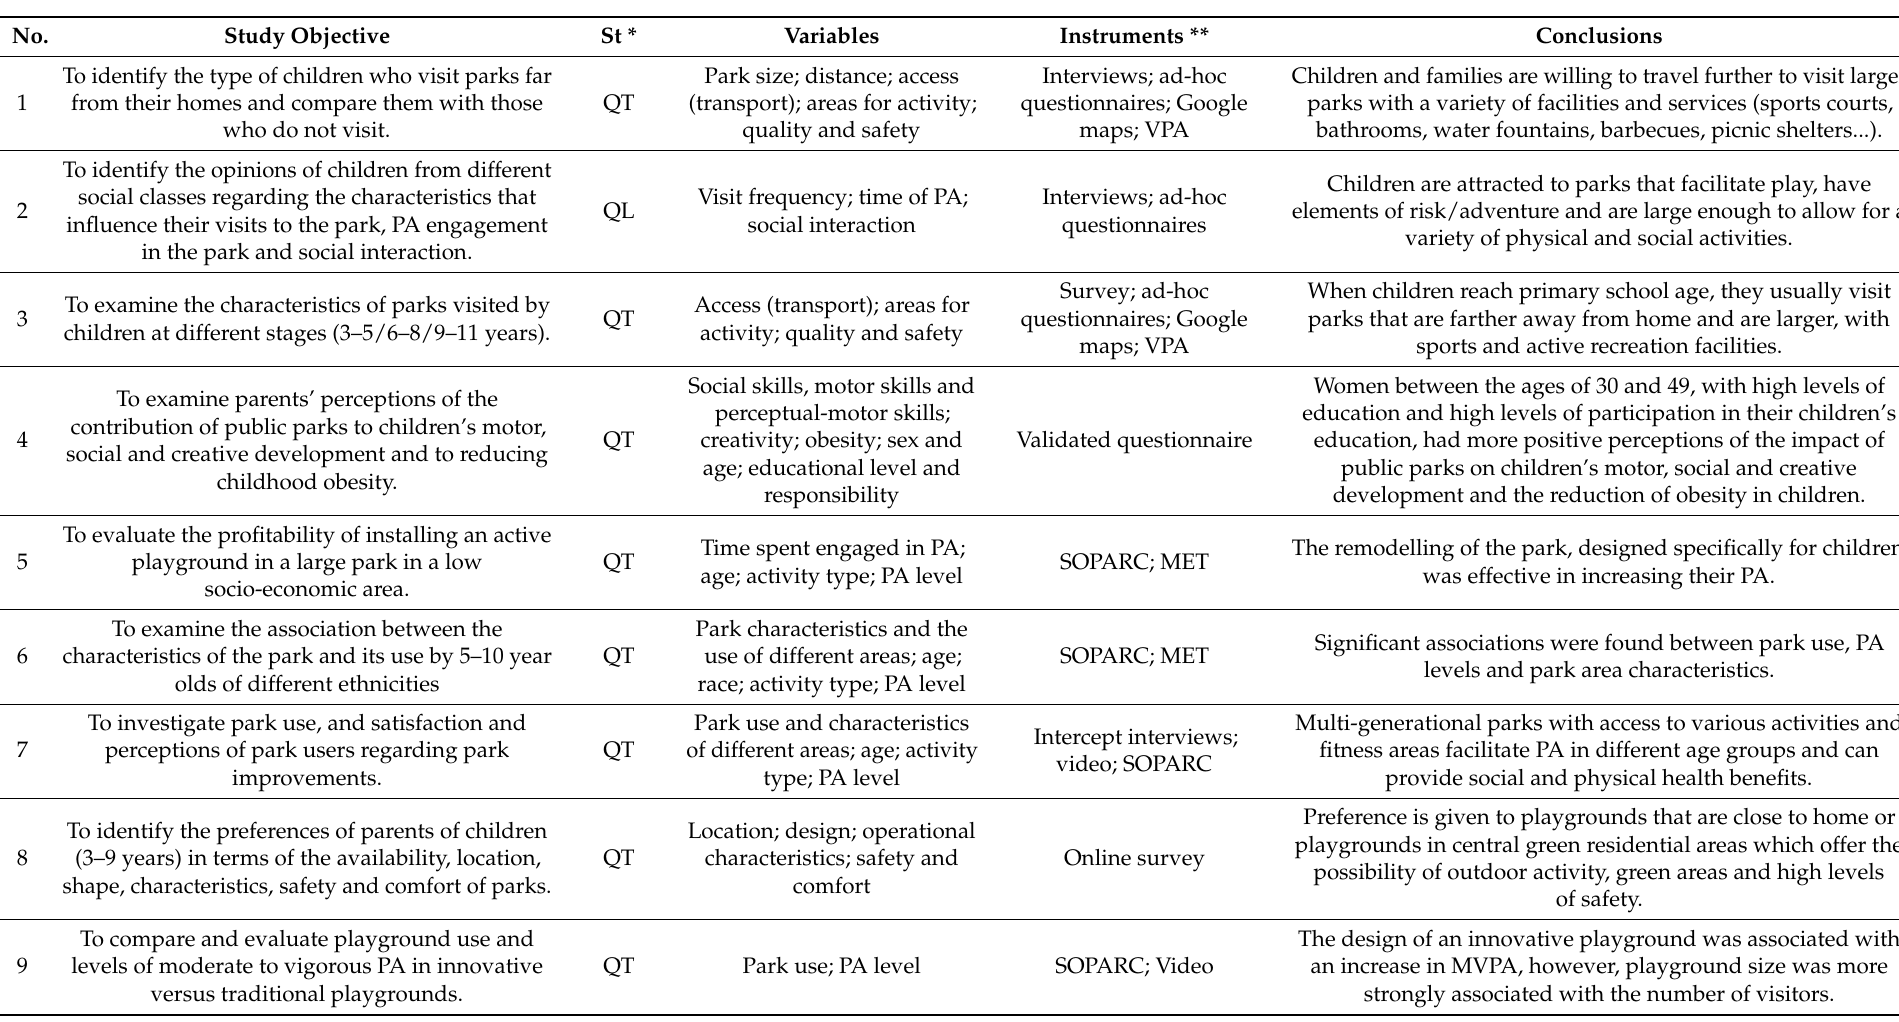
Table 2. Data related to the selected